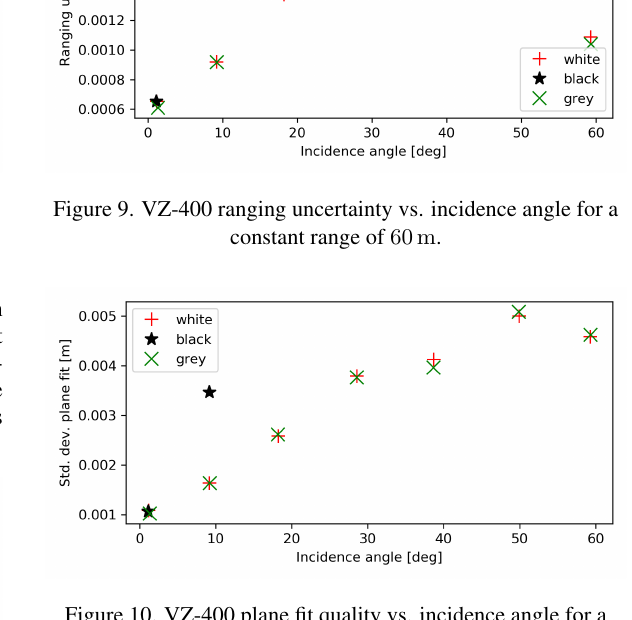
Figure 10. VZ-400 plane fit quality vs. incidence angle for a constant range of 60m .